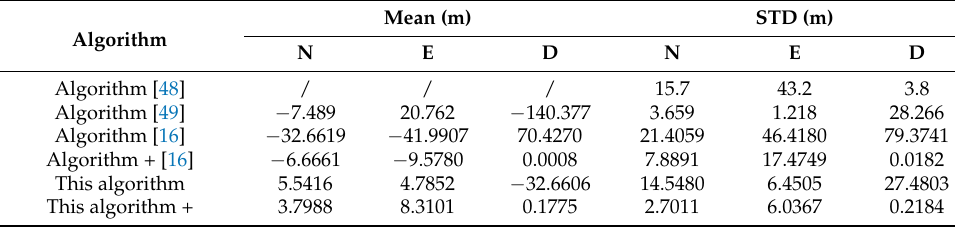
Table 3. Statistical comparison of position